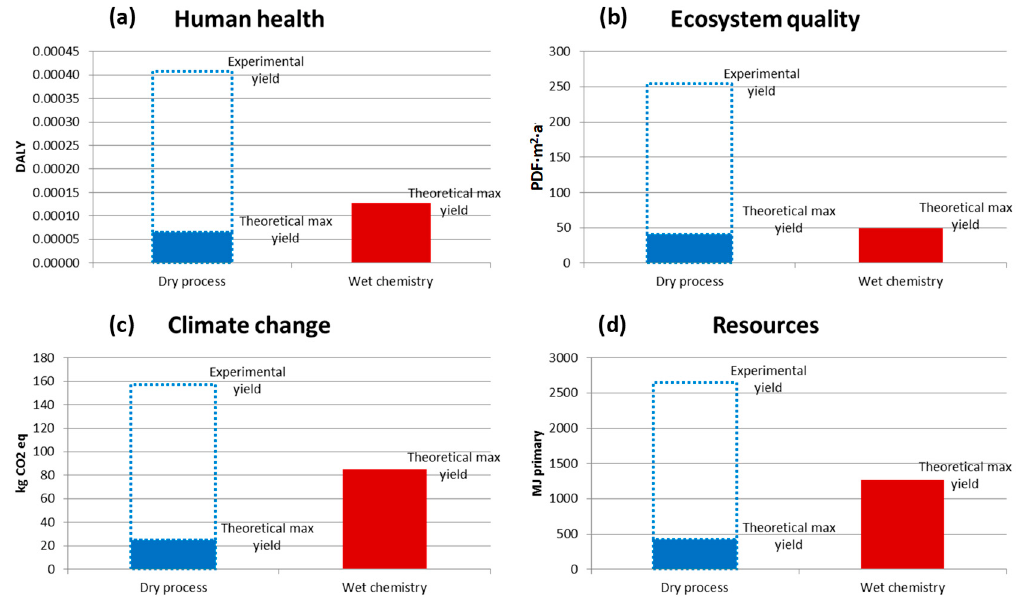
Figure 16. Life cycle impact (LCI) comparisons of dry, arc discharge NP production and chemical reduction methods for copper particles for four impact categories: Human health ( a ), Ecosystem quality ( b ), Climate change ( c ), Resources ( d ). See Figure 12 for the explanations of abbreviations.